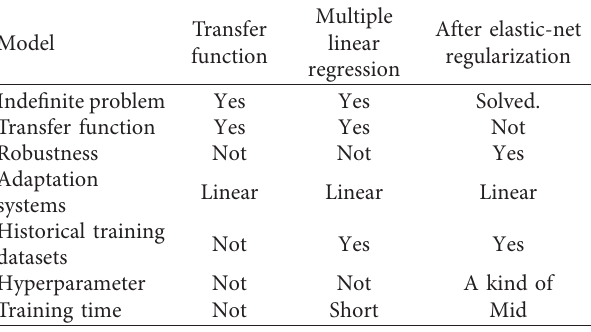
Table 2: Comparison of multipoint response prediction methods.